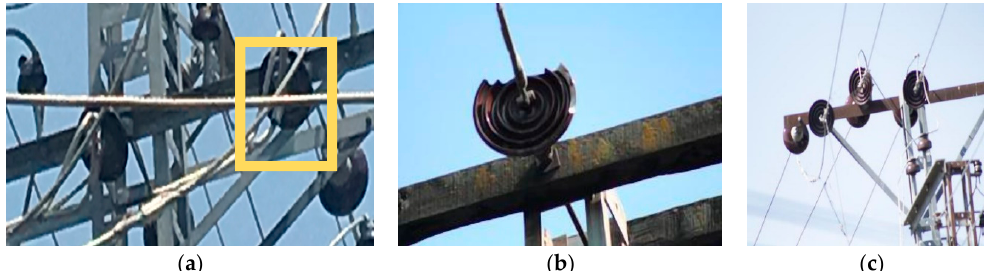
Figure A2. ( a ) Shuttering due to conductor and clipping wire. ( b ) Faulty insulator training image. ( c ) Normal insulator training image.